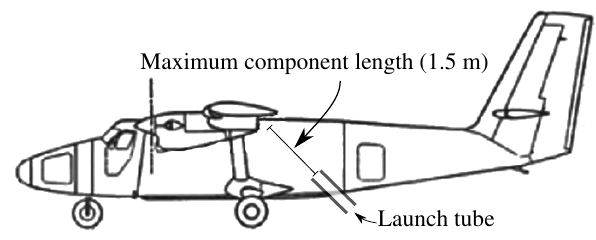
Fig. 4. Twin Otter aircraft fitted with sonobuoy launch tube. Figure 4. Twin Otter aircraft fitted with sonobuoy launch